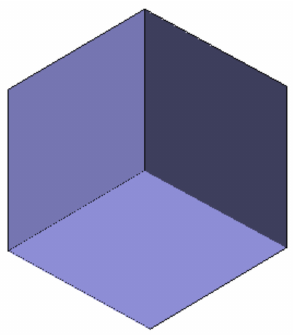
Figure 2. The trihedral angle